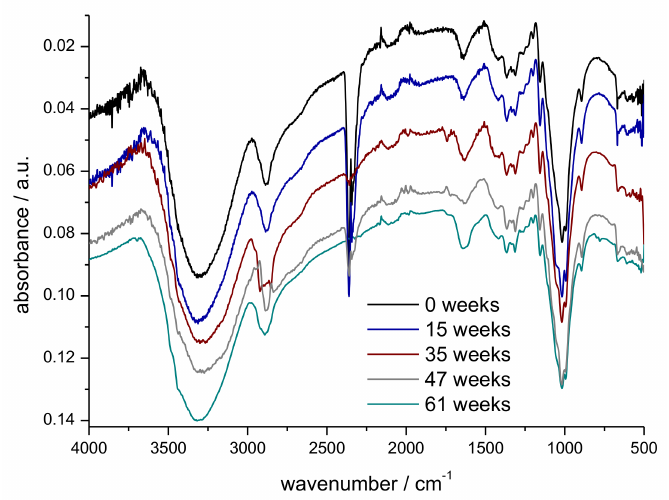
Figure 10. FTIR-ATR spectra of prototype 4 as function of exposure time in outdoor weathering (week 0, 15, 35, 47,